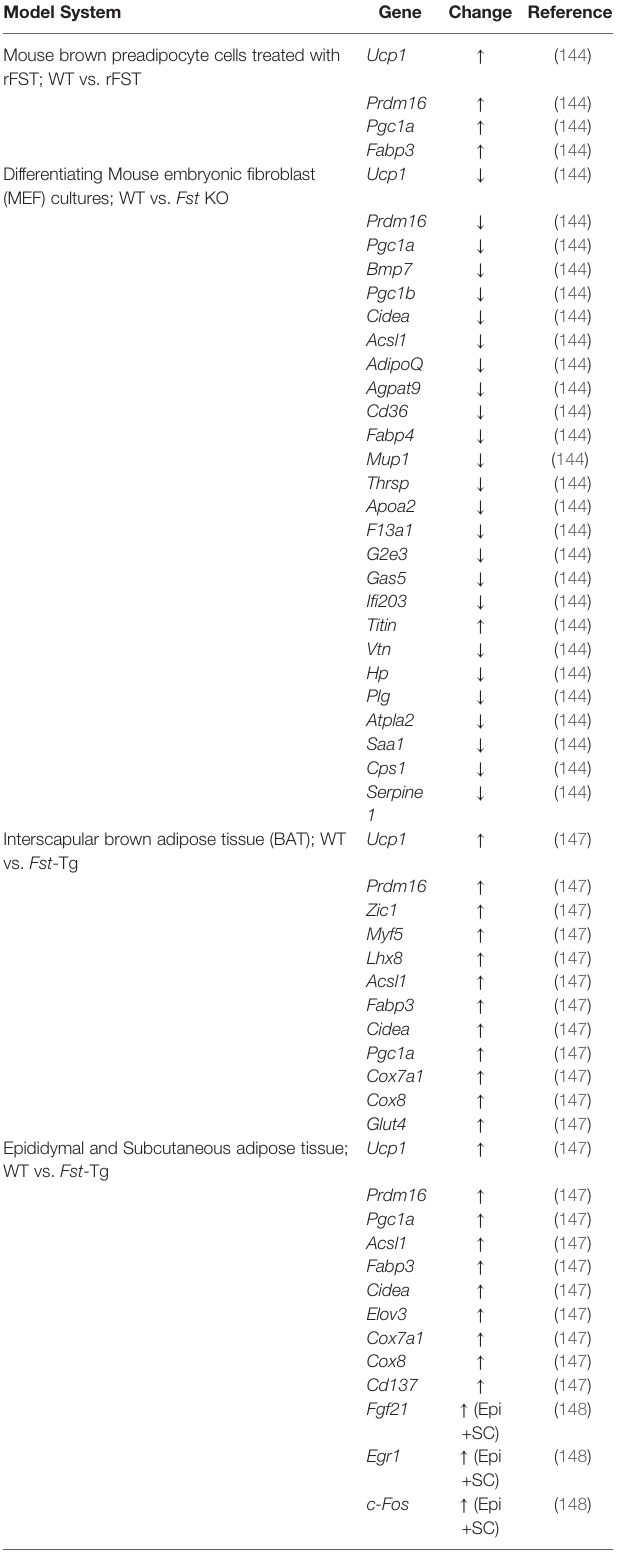
TABLE 2 | List of genes targeted by